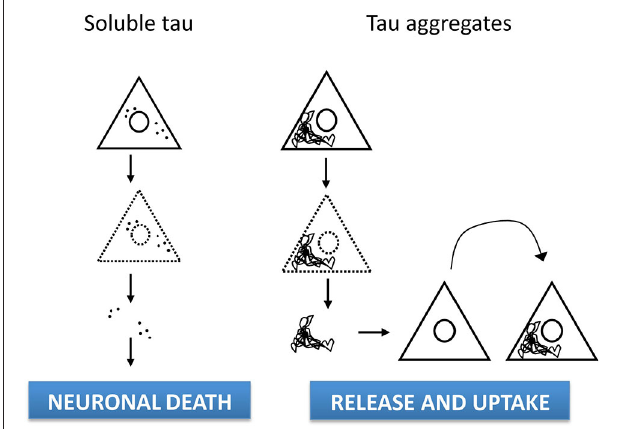
FIGURE 1 | Cell-to-Sources of extracellular tau and -cell spreading . The established view has long considered the presence of tau in the brain parenchyma or in the CSF as a consequence of tau protein being released after cell lysis. However, extracellular tau appears to result from a physiological process independent of cell death, as tau being can be released from cell lines and neurons via multiple pathways, either in naked form or vesicle-associated. In addition, tau misfolding in diseased brain leads to abnormal conformations of tau that can be taken up by surrounding neurons. Thus, pathological progression could involve transmission of tau protein through a prion-like mechanism resulting in neurodegeneration in susceptible brain